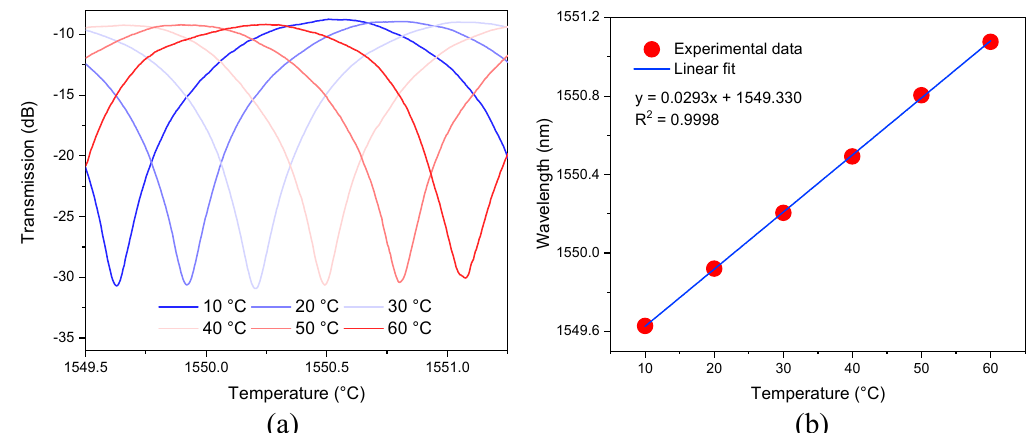
Figure 11. ( a ) Experimental spectra of the sensing MZI at different temperatures, ( b ) Wavelength shift of one dip of the spectrum as a function of temperature.